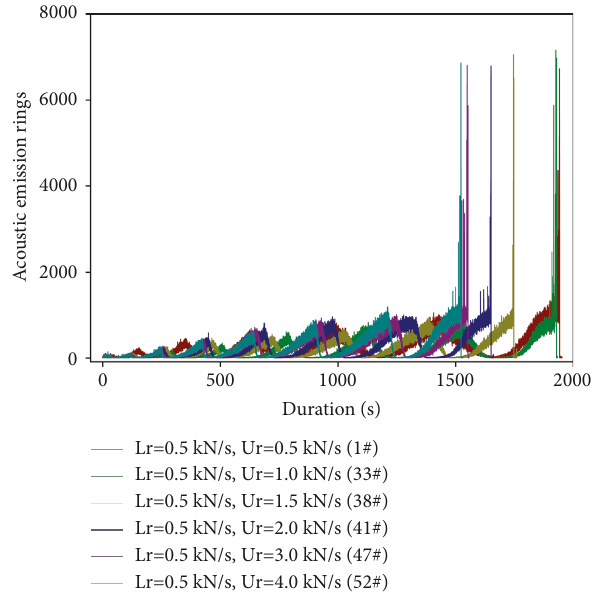
Figure 8: Changes of rock AE rings with the monitoring time under the uniaxial cyclic loading and unloading compression (Lr 0.5 kN/s, Ur 0.5kN/s ∼ (cid:30) (cid:30)